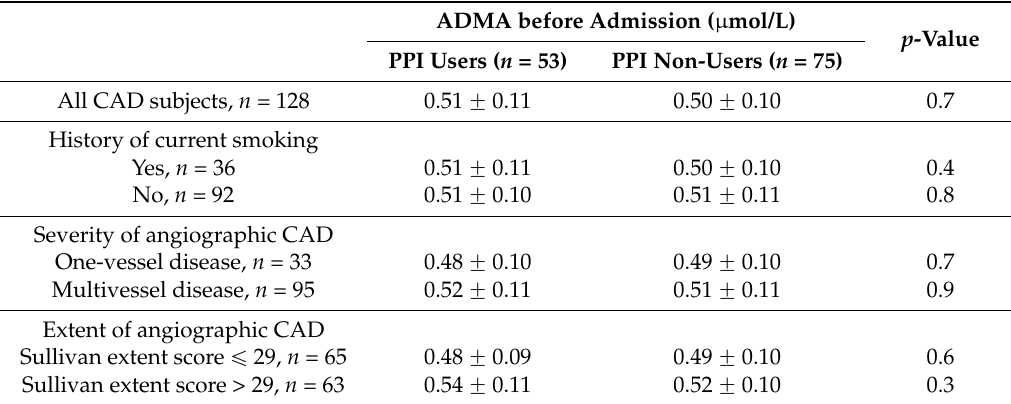
Table 2. Plasma ADMA levels according to PPI use prior to